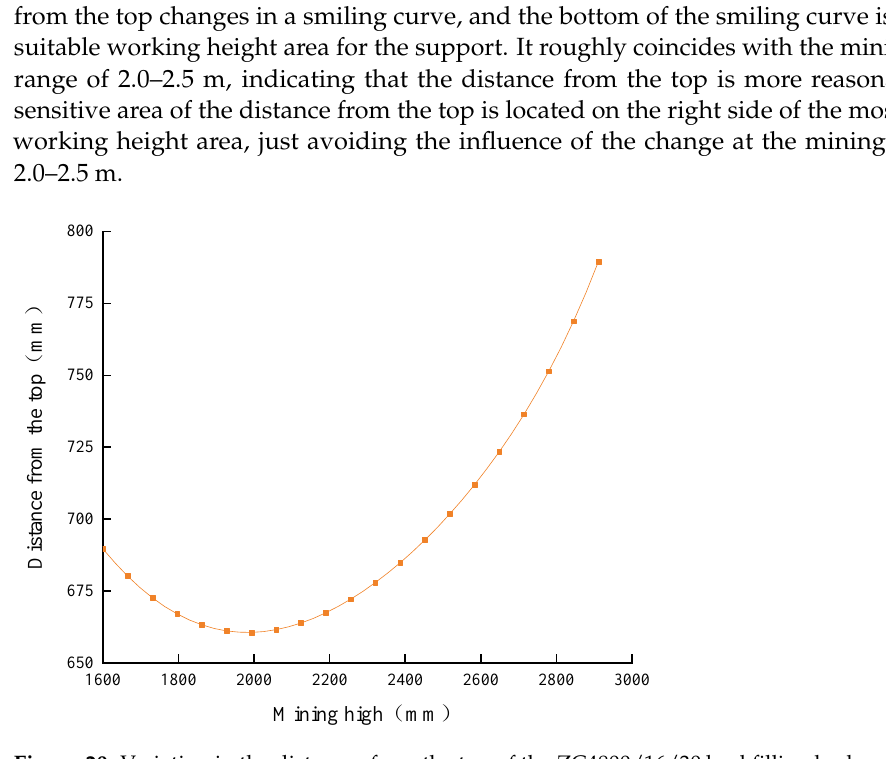
Figure 20. Variation in the distances from the top of the ZC4800/16/30 backfilling hydraulic support.